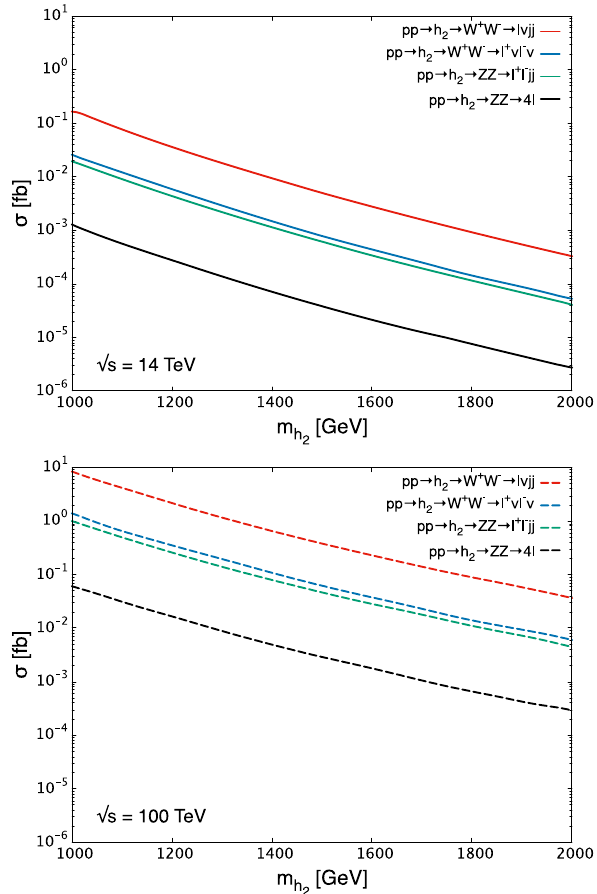
Fig. 6 Cross section (fb) times branching ratio as functions of m h the channels pp → h 2 → W + W − → l ν jj (red line), pp → h 2 → W + W − → l + ν l − ν (blue line), pp → h 2 → Z Z → l + l − jj (green line) and pp → h 2 → Z Z → 4 l (black line) for √ s = 100 TeV (down) and